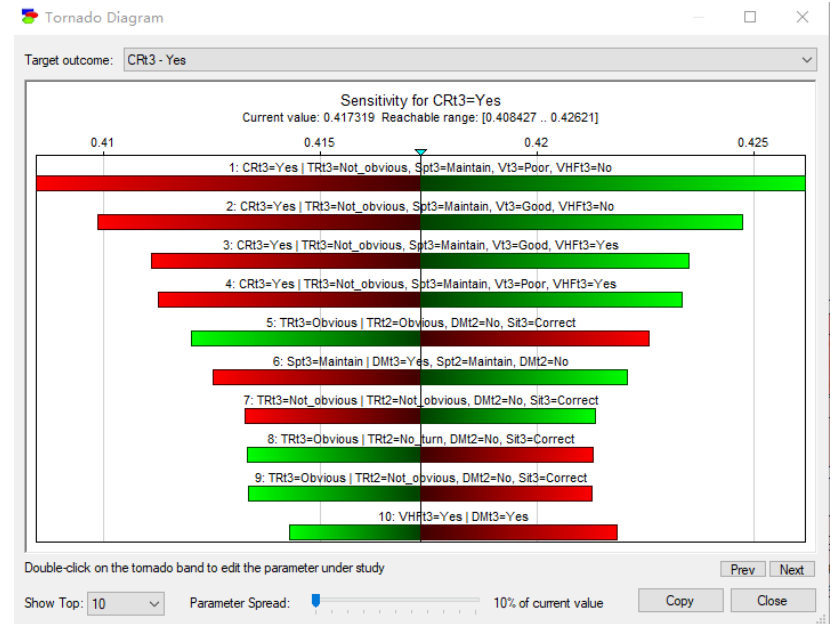
Figure 13. Tornado diagram with “CRt 3 ” as the target variable for sensitivity analysis. The important effects of TRt 3 , TRt 2 , VHFt 3 , DMt 3 , Spt 3 , DMt 2 , and Vt 3 and their result- ant statistical sensitivity numerical values are shown in Table 7. Table 7. Sensitivity analysis results.